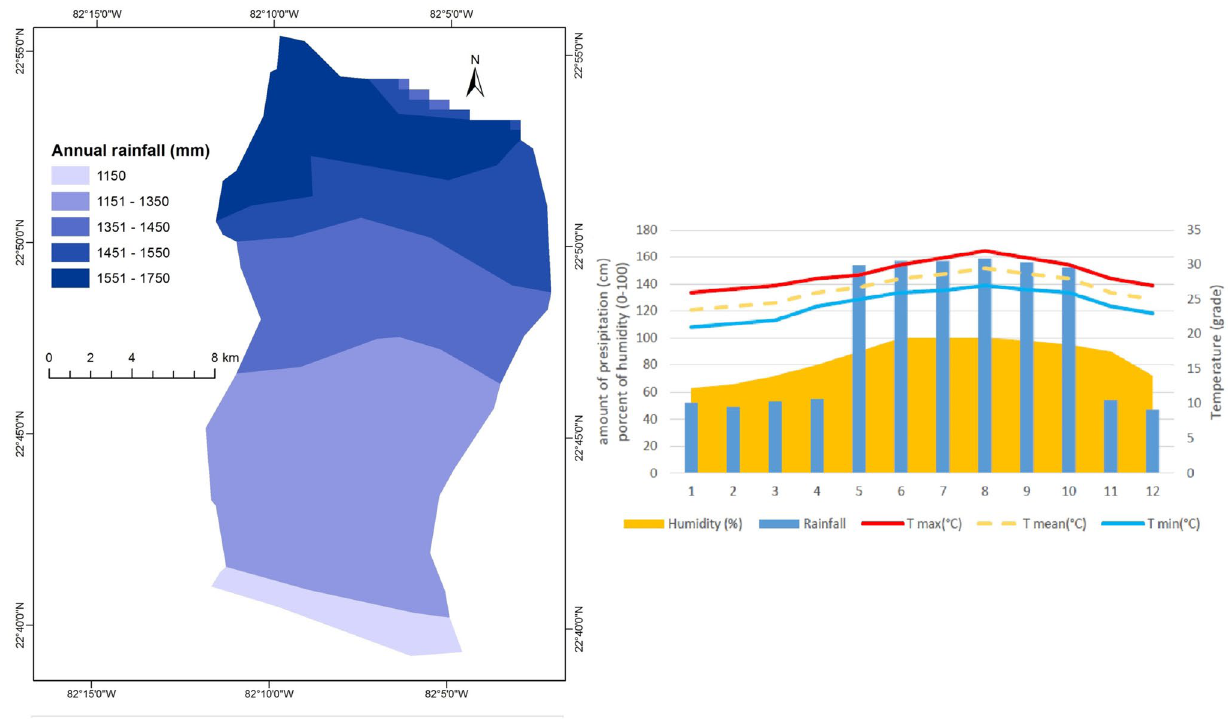
Fig. 4 Accumulated rainfall between 2010 and 2018 in the basin [47]